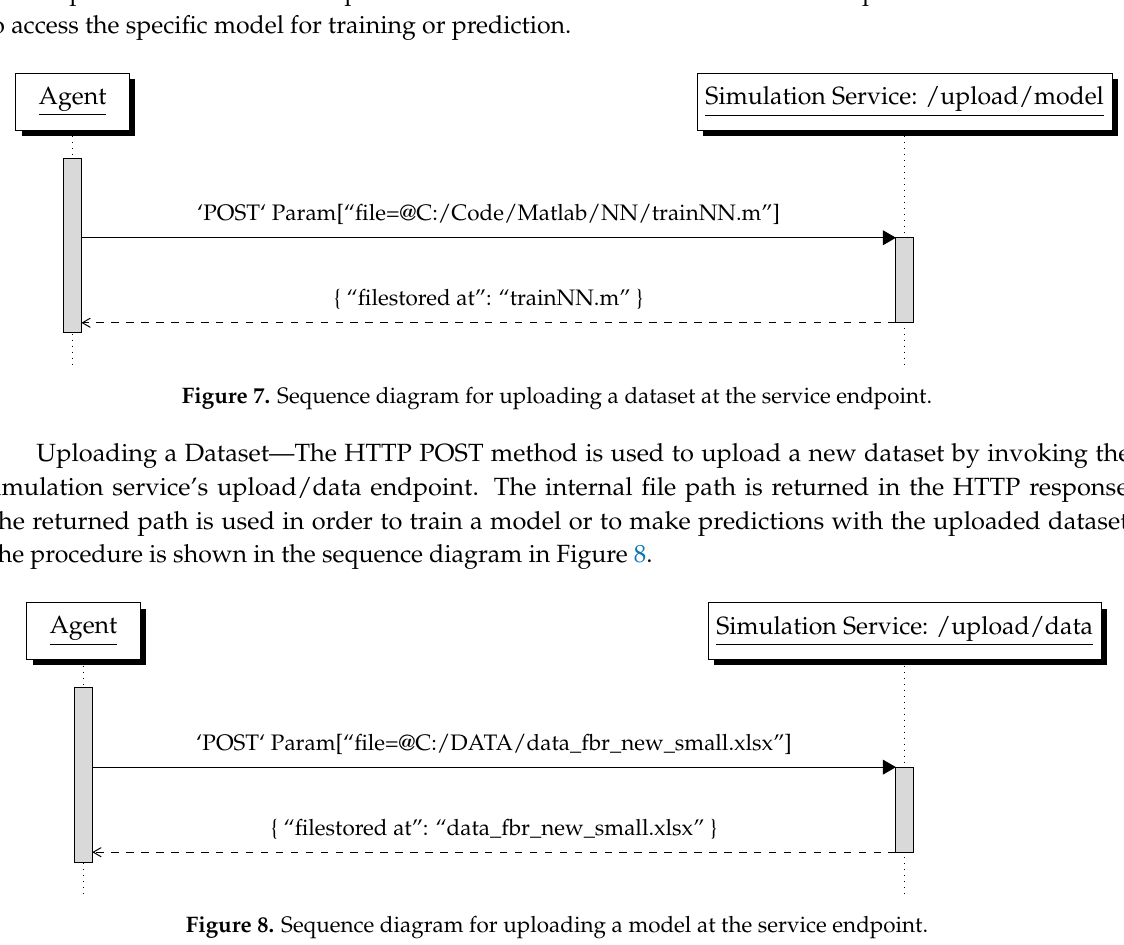
Figure 8. Sequence diagram for uploading a model at the service